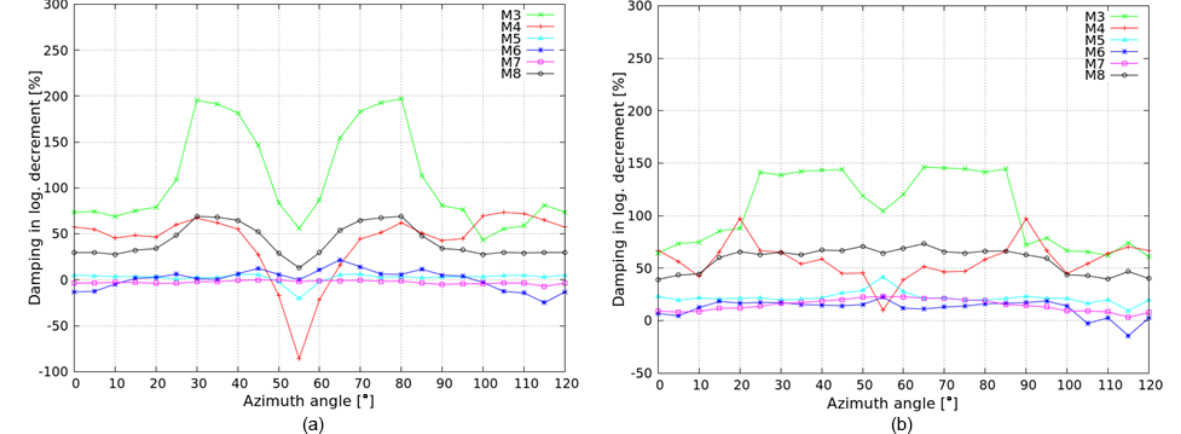
Figure 23. Modal damping of rotor modes versus azimuth angle at U = 42 . 5ms − 1 and yaw = 45 ◦ . (a) Steady-state aerodynamics and (b) unsteady aerodynamics (ONERA modeling).